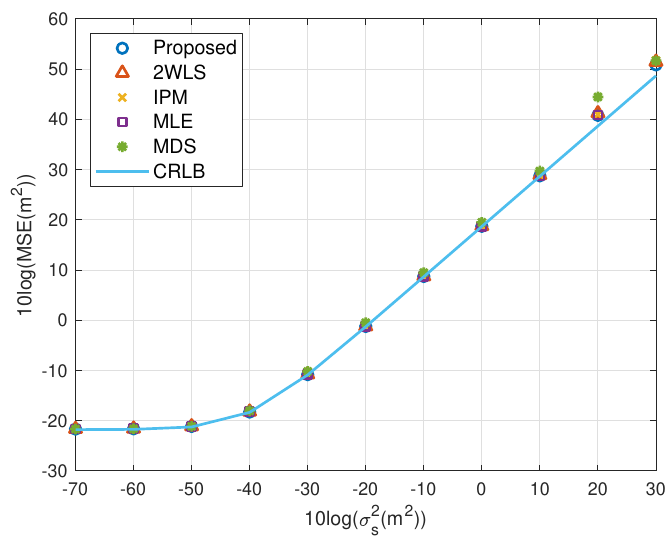
Figure 12. MSE performance as error level increasing (near source, 6 sensors).